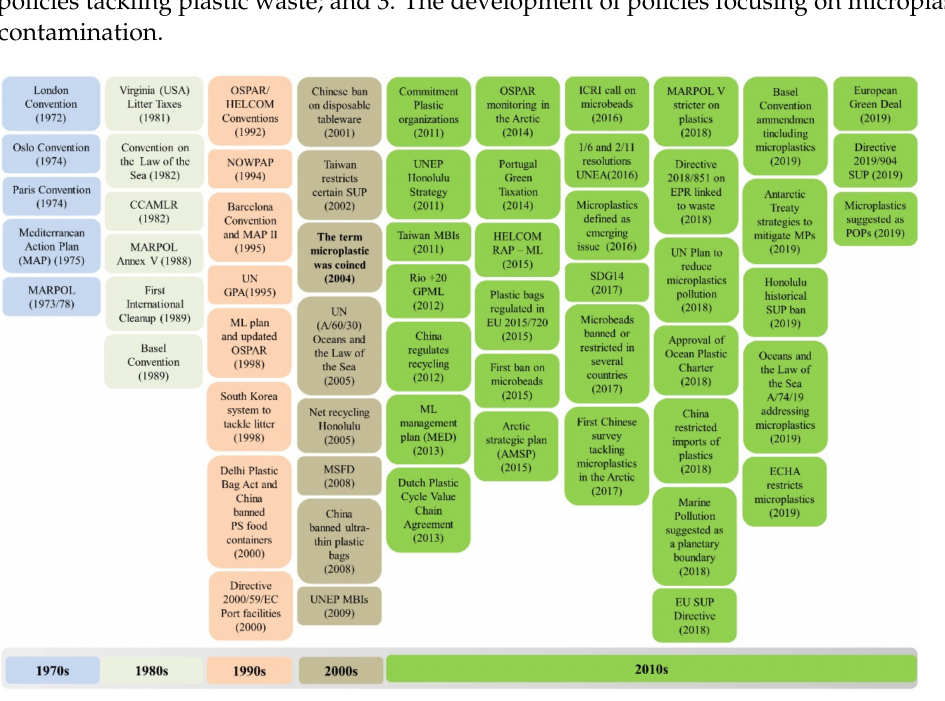
Figure 1. Timeline of policies targeting plastic and microplastic contamination. Table 1. Summary of chief policies in place directly addressing